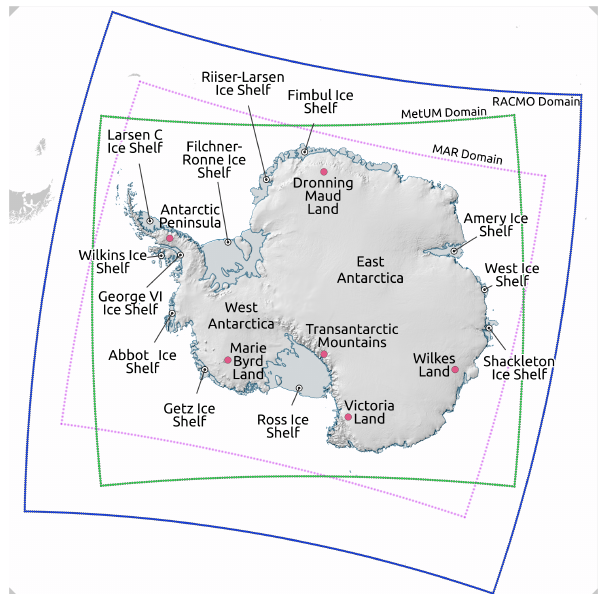
Figure 1. Map of Antarctica with some of the main regions and ice shelves labelled, made using the Quantarctica mapping environ- ment (Matsuoka et al., 2021). The RCM simulation domains for the MetUM (green), RACMO (blue) and MAR (purple) are shown. A 1km resolution hillshade has been applied from Bedmap2 (Fretwell et al.,